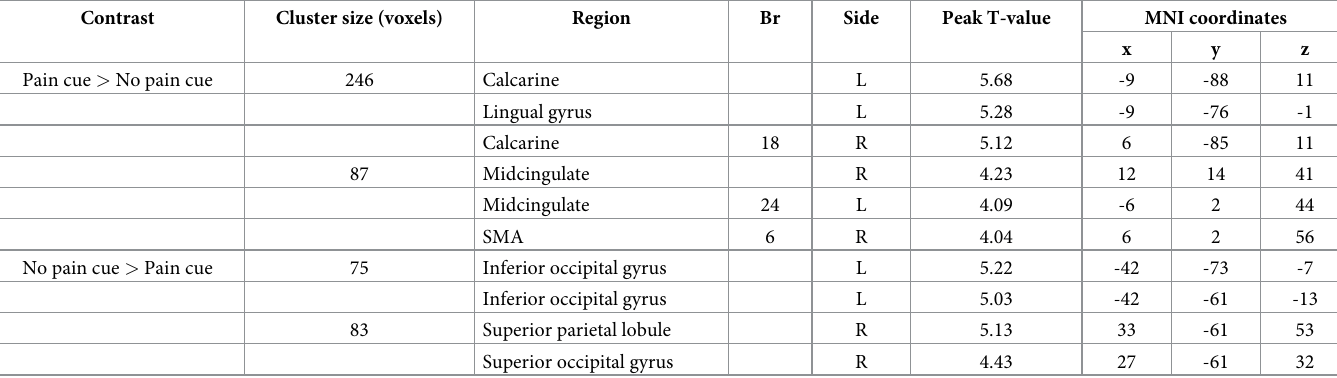
Table 3. Activation changes during pain anticipation (N = 23). Contrast